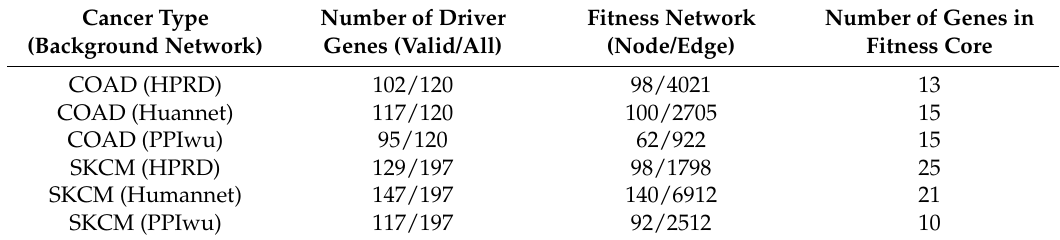
Table 1. Statistics of results obtained in case